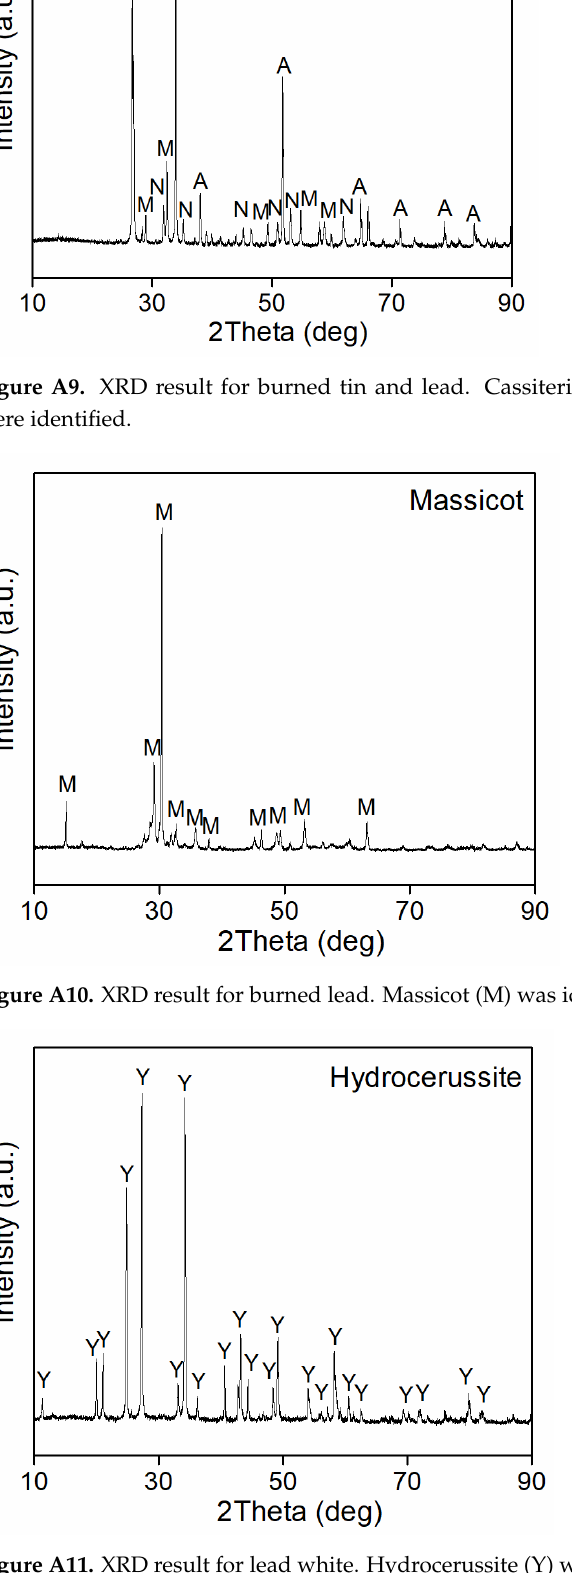
Figure A12. XRD result from the model grisaille. Hematite (H), tenorite (T), and cuprite (C) were identified.